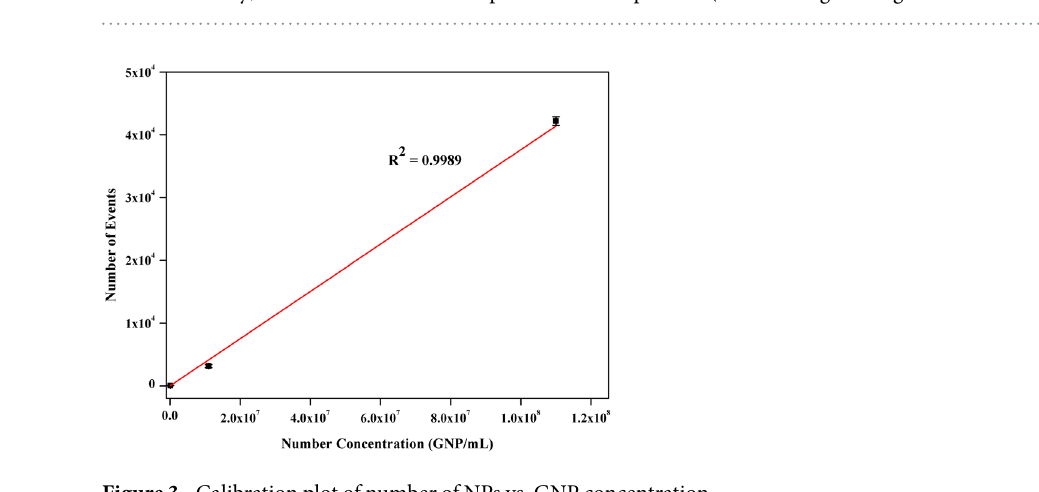
Figure 2. SEM images of GNPs on kidney ( a ) and determination of GNP size (a1 and a2). ( b ) Images of ablated GNPs on kidney; the area outlined in red represents the LA product (shown at higher magnification in b1).